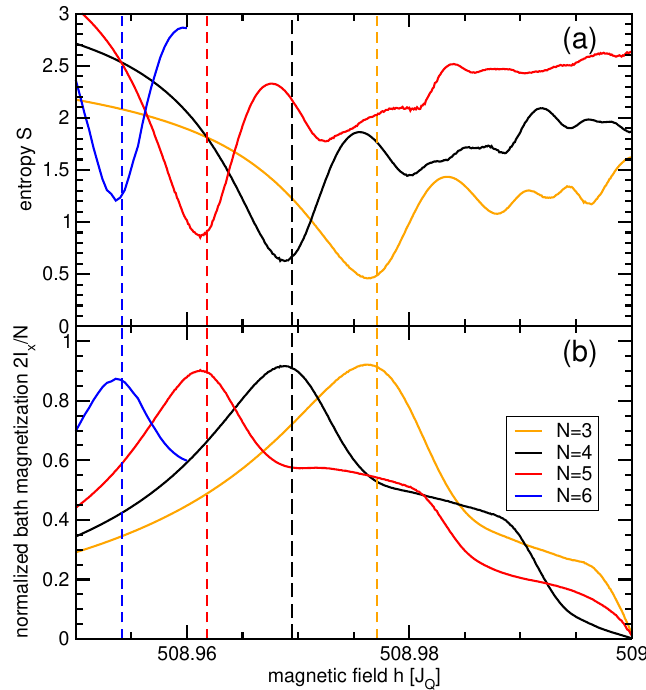
Figure 2: (a) Residual entropy of the limiting density matrix V other parameters as in Fig. 1. The dashed lines indicate the shifts of the electronic resonance by − A . (b) Corresponding normalised polarisation of the spin bath in max the external field direction, i.e. the x